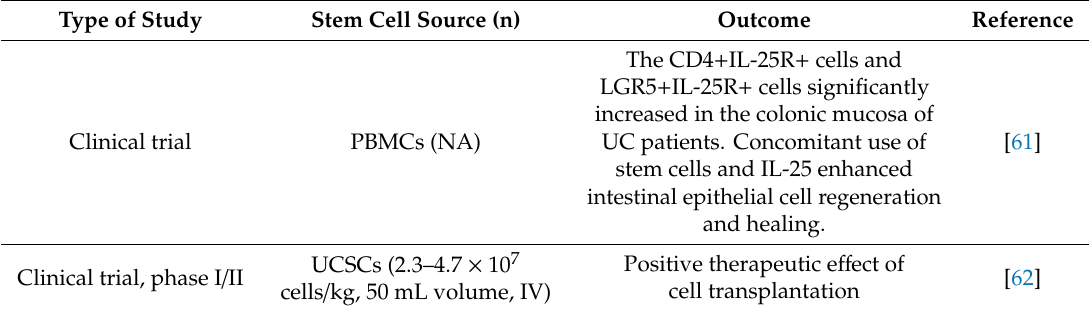
Table 2. Undertaken clinical trials in the treatment of UC by various sources of MSCs. Type of